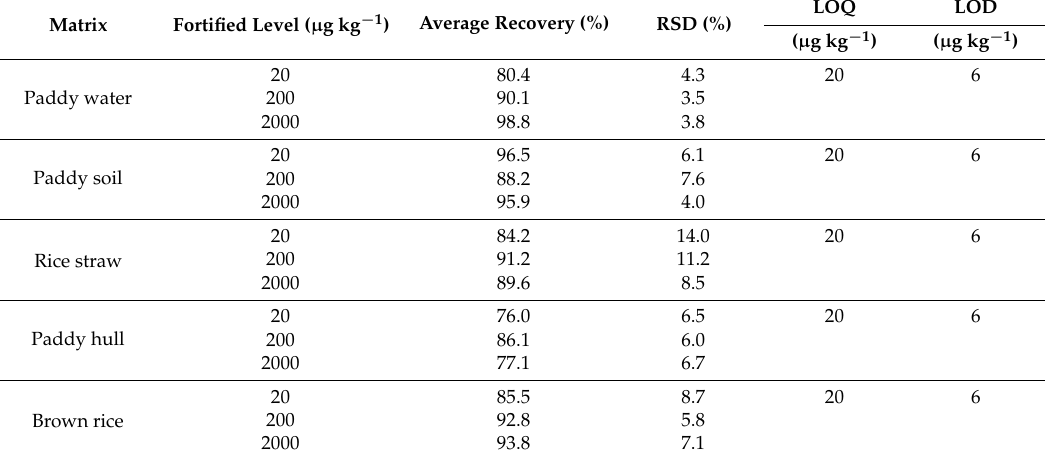
Table 3. Fortified recoveries ( n = 5) and relative standard deviations (RSDs) of oxadiargyl in paddy water, paddy soil, rice straw, paddy hull, and brown rice. LOQ—limits of quantification; LOD—limits of